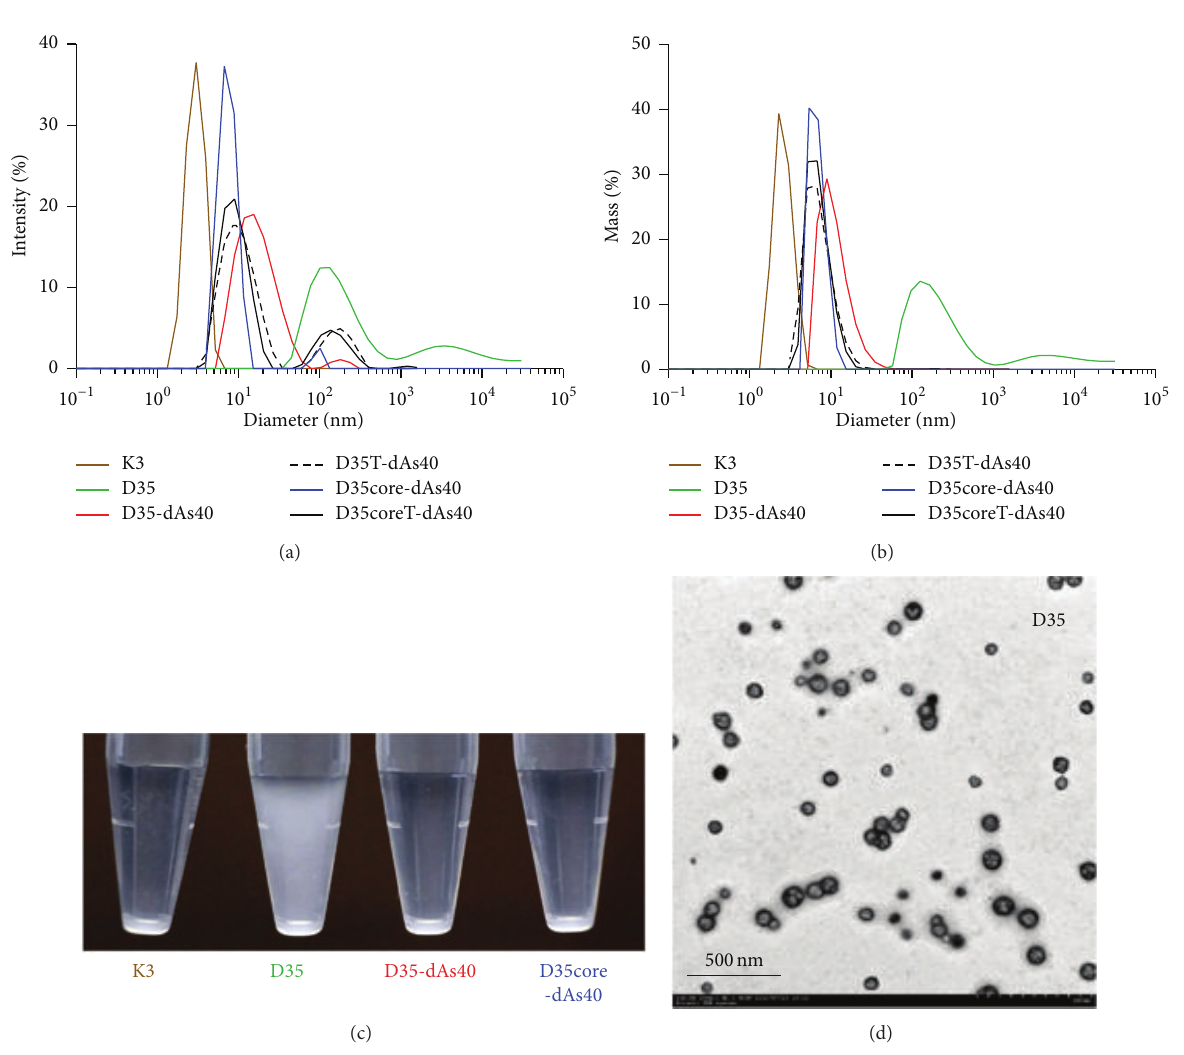
Figure 3: Physical properties of polynucleotide tailed A/D type ODNs in PBS solution. DLS analysis of the indicated ODN solutions (each 1.0mg/mL in PBS) by % intensity plot (a) or % mass plot (b). See Table 2 for each measurement. (c) Turbidity status of the indicated ODN solution. The indicated ODNs were initially dissolved in distilled water at a concentration of 10mg/mL (all ODNs were completely solubilized with water and the solutions were clear) and further diluted with PBS at a final concentration of 1.0mg/mL. Solutions were stored at 4 ∘ C for at least 18 hours and then images were captured. D35 developed visible white turbidity during this incubation. In contrast, other ODNs were clear. (d) TEM image of aggregated D35 in PBS similarly prepared as in (c).